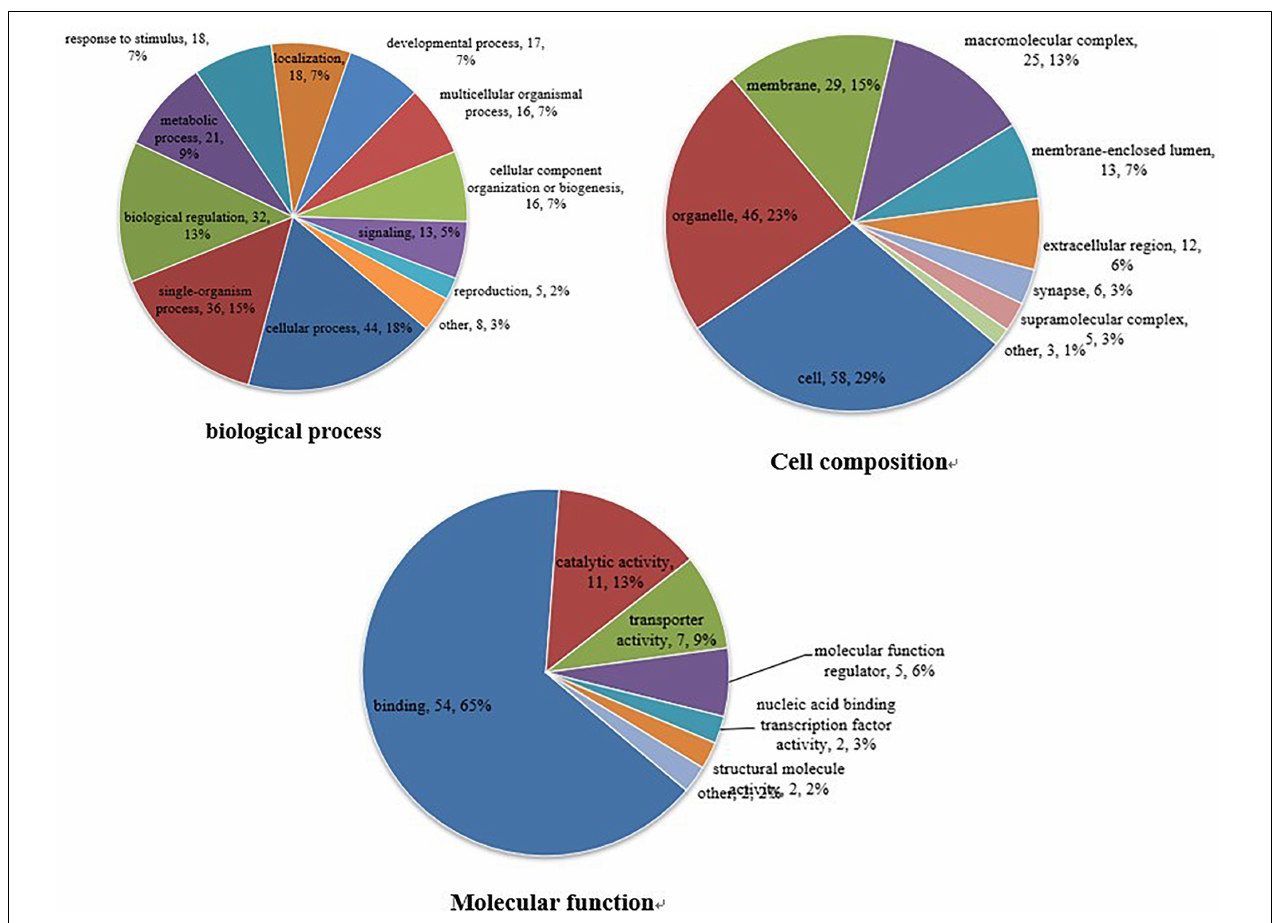
FIGURE 3 | Gene ontogeny (GO) annotation. Differentially abundant proteins were annotated according to molecular function, cell composition, and biological process. Differentially abundant proteins are mainly annotated as ‘protein binding,’ ‘cell,’ and ‘cell process,’ respectively, in terms of molecular function, cell composition, and biological process.